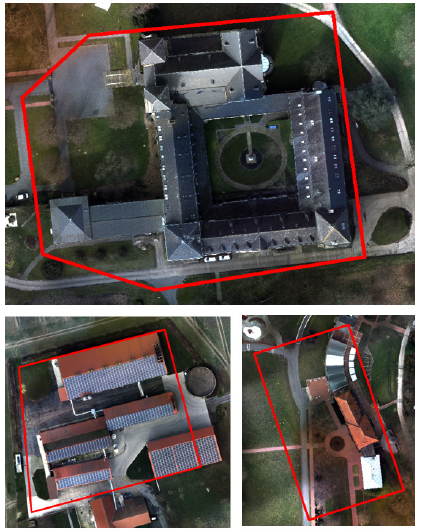
Figure 8: Selected areas for point-to-plane based comparison Depending on the performance of the BBA the quality of dense matching outputs varied. Thus, not all selected planes showed